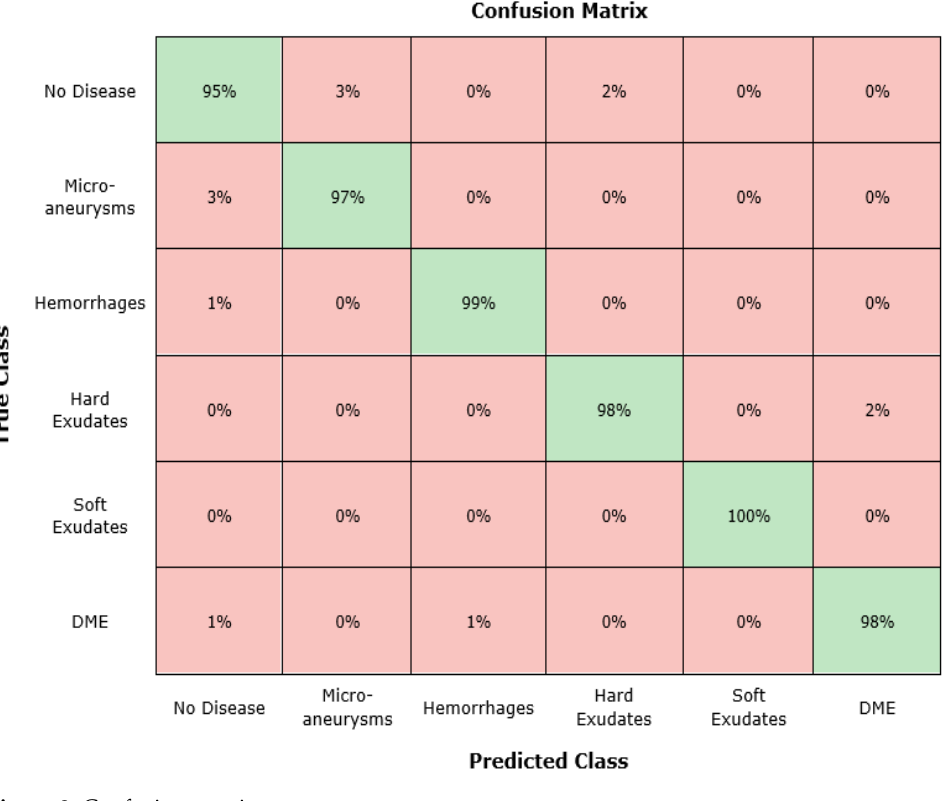
Figure 8. Confusion matrix.